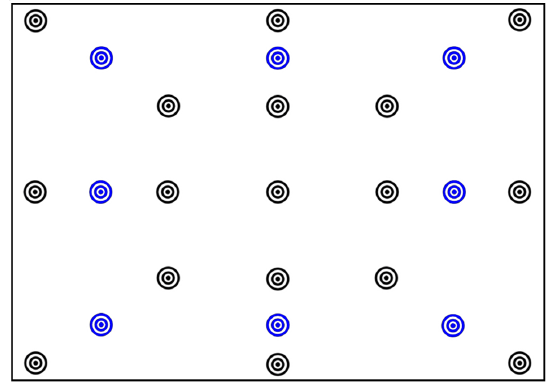
Figure 6: Points used for Calibration (black) and Validation (blue). The fixation point is shown in one of the locations at a